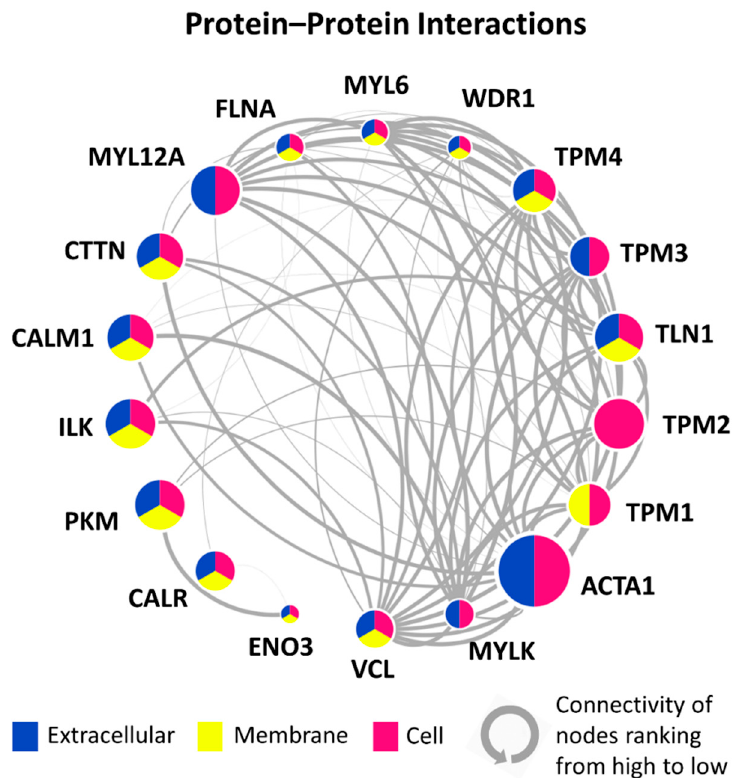
Figure 4. Protein–protein interaction (PPI) network among the upregulated muscle-related DEPs. The colors of each node (DEP) represent its location. The size of the node indicates its mean ratio of the P vs. NP groups. The nodes are sorted from VCL to ENO3 by the degree of connectivity calculated by Cytoscape and listed in a circle. The line (interaction) thickness indicates the interaction score calculated by STRING, which represents the strength of data support.